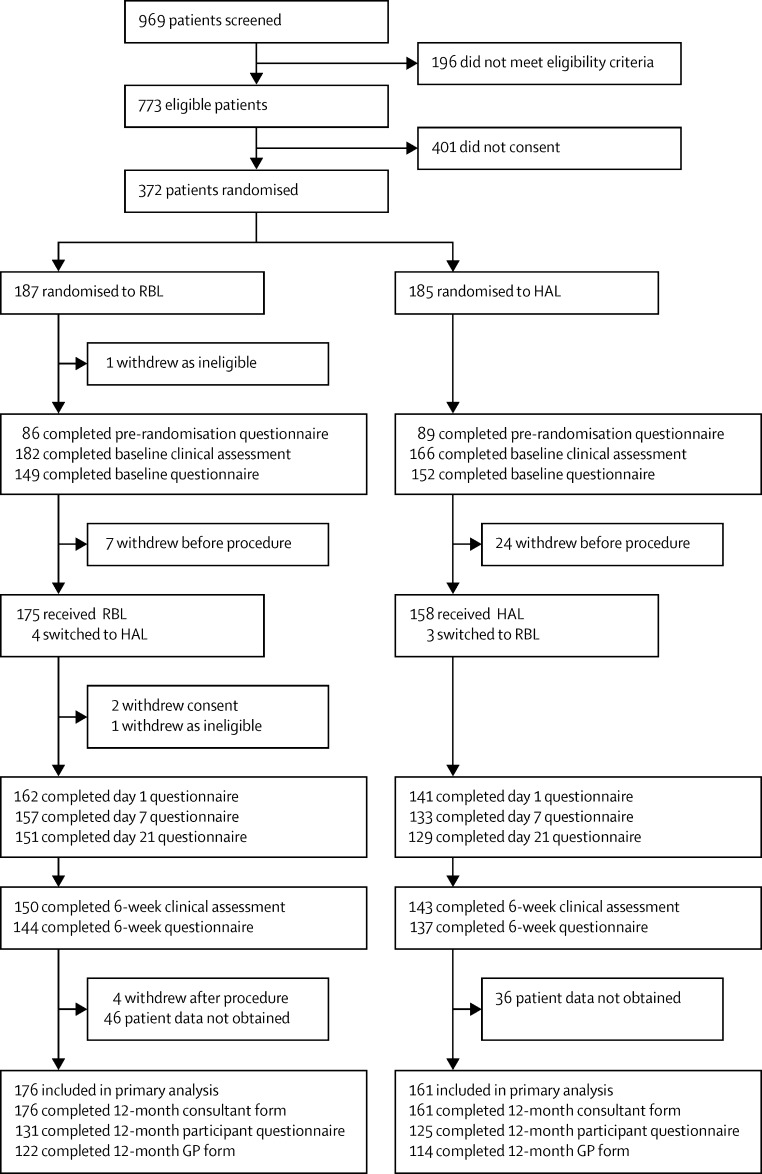
Trial profileRBL=rubber band ligation. HAL=haemorrhoidal artery ligation.